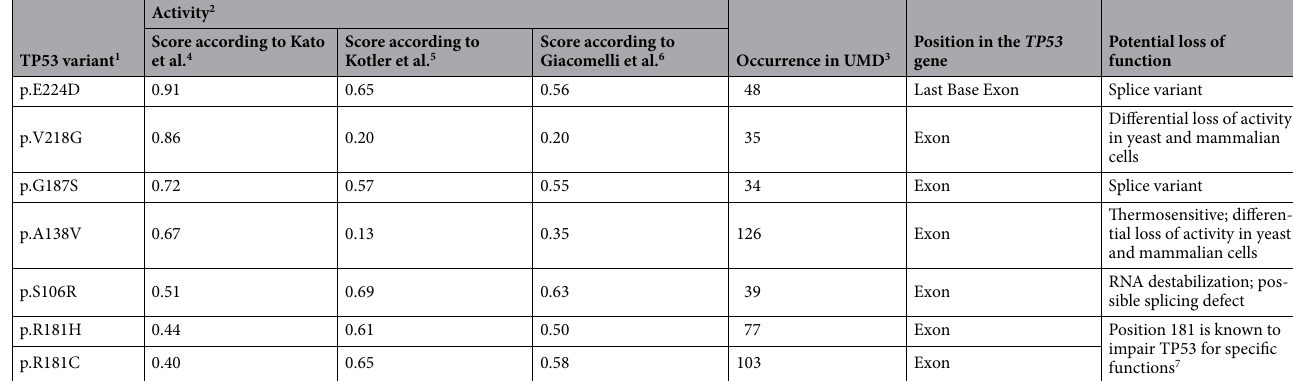
Table 1. Alternative loss of function of the 7 CSD TP53 variants. 1 The sequence nomenclature used for TP53 variants in this work is in accordance with the Human Genome Variation Society’s guidelines using the NM_000546.5 transcript sequence and the full-length protein NP_000537.3. 2 TP53 functional data were scaled in the range of 0 to 1 with 0 corresponding to the lowest activity of TP53 variants. 3 Number of tumors expressing each TP53 variant included in the TP53_UMD. 4 Data from the transcriptional activity performed in yeast using 8 different p53 response elements (mean of the activities for the 8 readouts) from the work of Kato et al. 9 . 5 Score from the growth arrest assay in H1299 cells performed by Kotler et al. 11 . 6 Mean score from the three assays performed by Gacomelli et al. 12 (see "Methods" for a full description of the assays). 7 Both in vitro studies and mouse models indicate that these variants are functionally defective 21,32